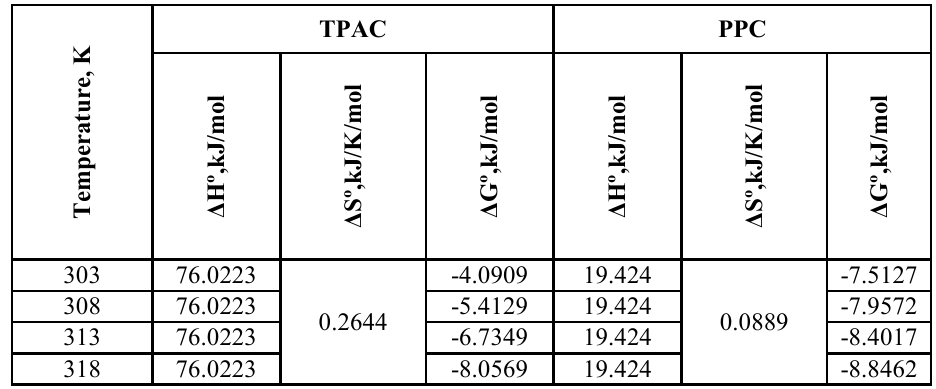
Table 4. Thermo dynamical parameters from Van’t Hoff plots for the adsorption of direct dye DB 71 onto TPAC and PPC at various